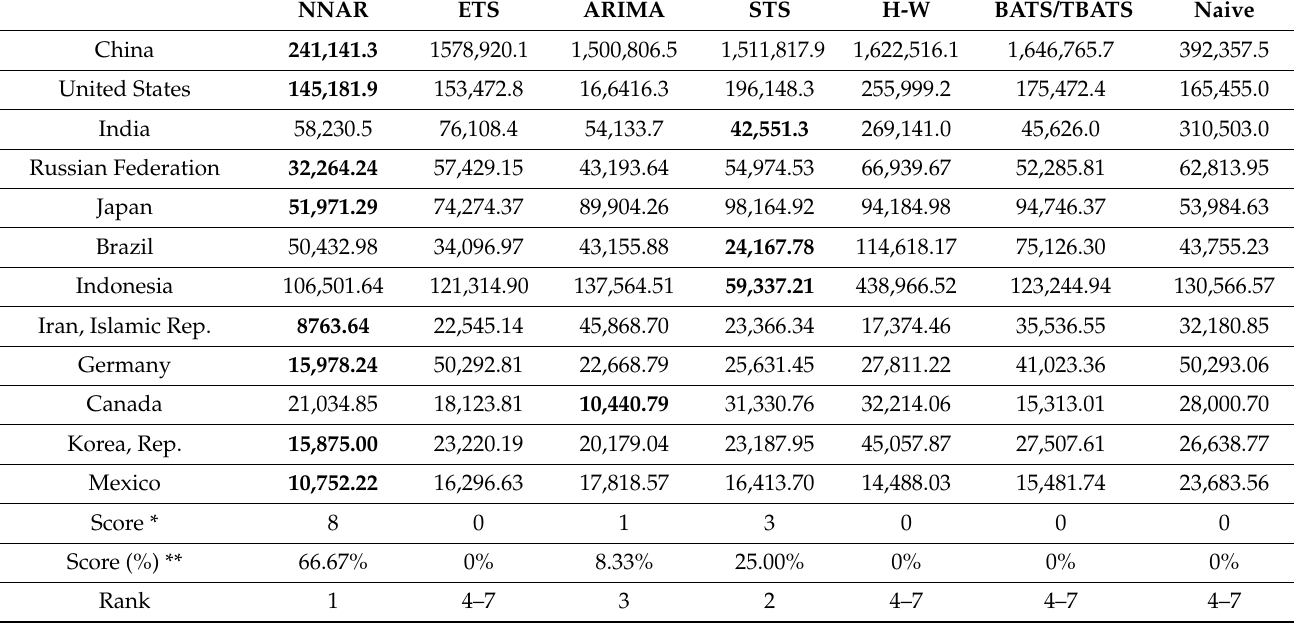
Table 2. Forecasting accuracy (RMSE for out-of-sample forecasting at h = 5). NNAR ETS ARIMA STS H-W BATS/TBATS Naive